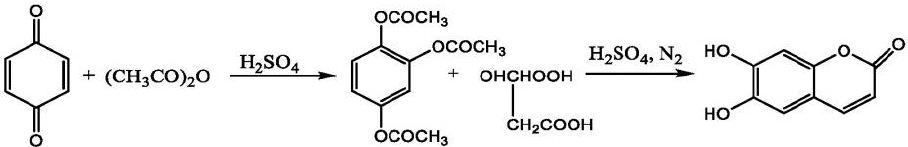
Figure 10. Synthesis of esculetin using p-benzoquinone, sulfuric acid and acetic anhydride.